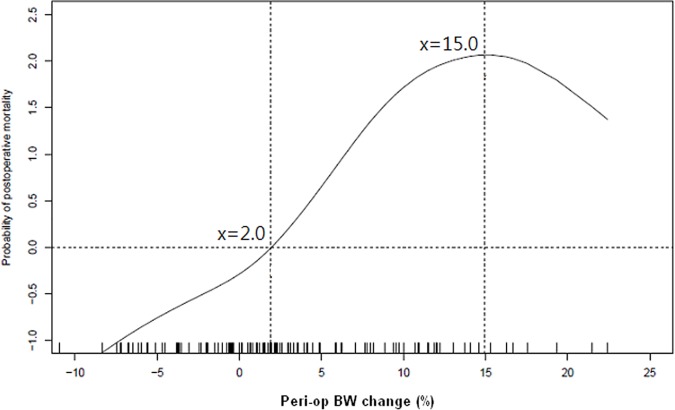
The probability of 30-day postoperative mortality according to the perioperative body weight changes.Note: The plot was drawn using a generalized additive model with adjustment for all other independent predictors, including perioperative packed red blood cells transfusion, postoperative intra-aortic balloon pump use, postoperative central venous pressure level, as well as heart rate, Sequential Organ Failure Assessment Score, Logistic Organ Dysfunction Score, and blood total bilirubin level at renal replacement therapy initiation. The estimated probability of 30-day postoperative mortality raised gradually accompanying the increase of perioperative BW change. The estimated probability started to increase significantly when the perioperative BW change reached 2.0% and reached the peak level when the BW change arrived at 15.0%. Abbreviations: BW, body weight; Peri-op, perioperative.